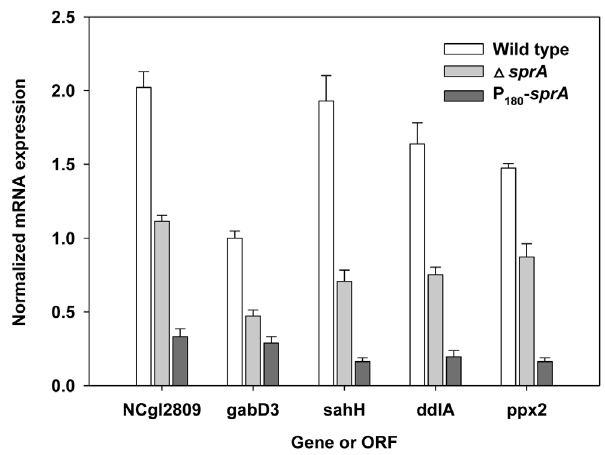
Figure 9. Transcription of genes in C.glutamicum strains. Cells were grown in glucose MCGC media, and mRNA levels were measured by RT-qPCR as described in the Materials and Methods. The data represent three independent experiments. Bars indicate mRNA levels in wild-type (empty bars), D sprA (light grey bars), and P 180 - sprA (dark grey bars)